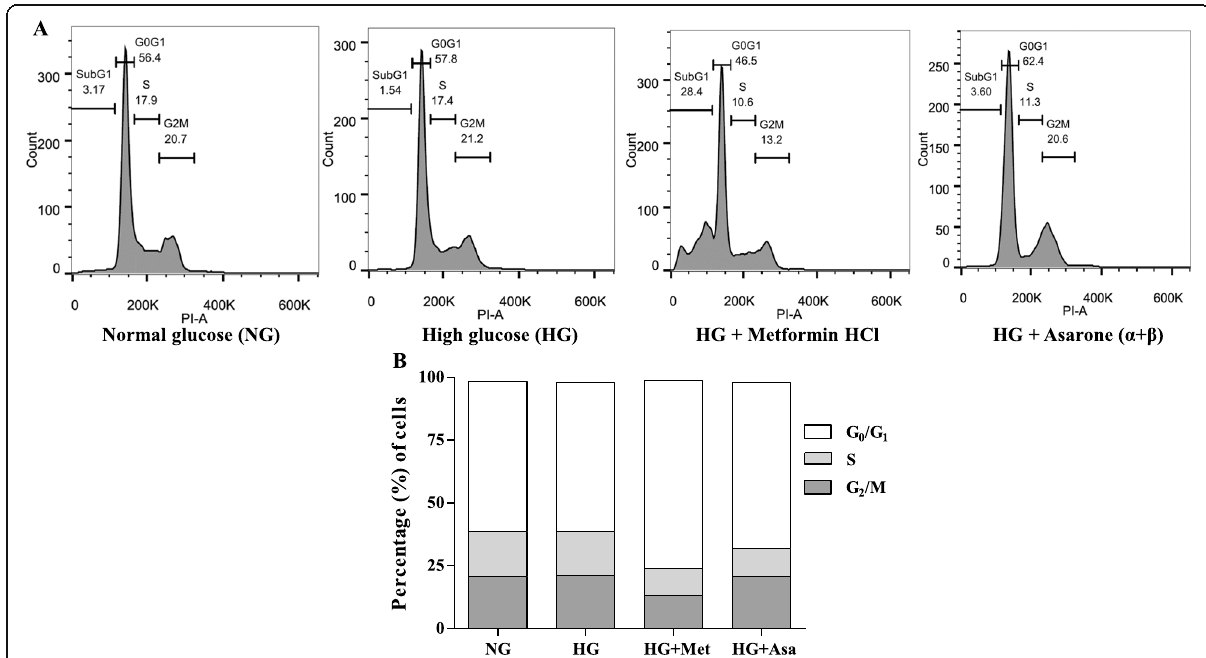
Fig. 3 Metformin and asarone block HepG2 cells in G 0 /G 1 phase in hyperglycemic condition a Cell cycle profile of HepG2 cells cultured in normal glucose (NG; 5.5 mM), high glucose (HG; 25 mM), HG + Metformin HCl, and HG + Asarone for 16 h and stained with PI-RNase was determined by flow cytometry. b Bar diagrams represent the percentage (%) of cells in different phases of the cell